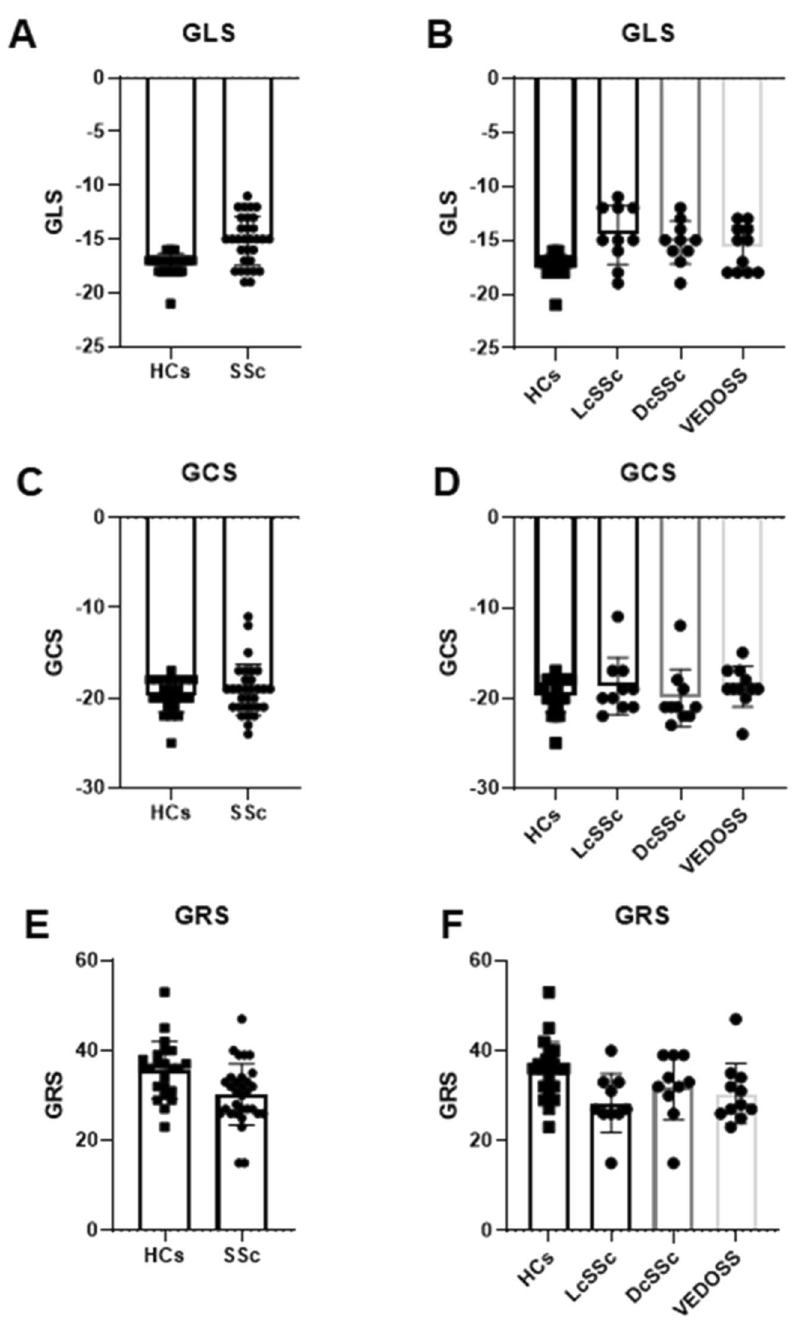
Figure 1. Graphical representation of strain values distribution. ( A ), ( C ) and ( E ) show the comparison between healthy and overall SSc values. In ( B ), ( D ) and ( F ), strain distribution for subset